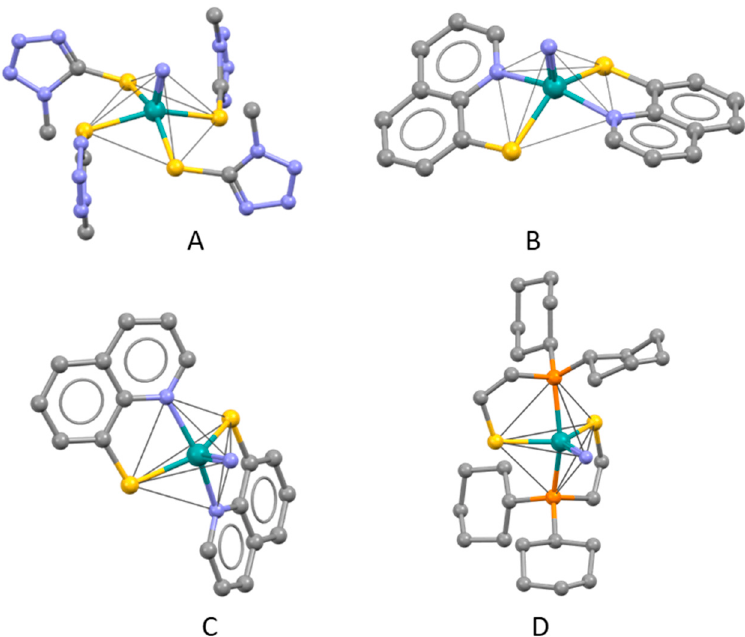
Figure 3. Square pyramidal versus trigonal bipyramidal geometries. Structures of ( A ) [TcN(Smetetraz) 4 ] 2 − , ( B , C ) TcN(C 9 H 6 NS) 2 in sp and tbp arrangements, respectively; ( D ) TcN(SCH 2 CH 2 PCy 2 ) 2 .